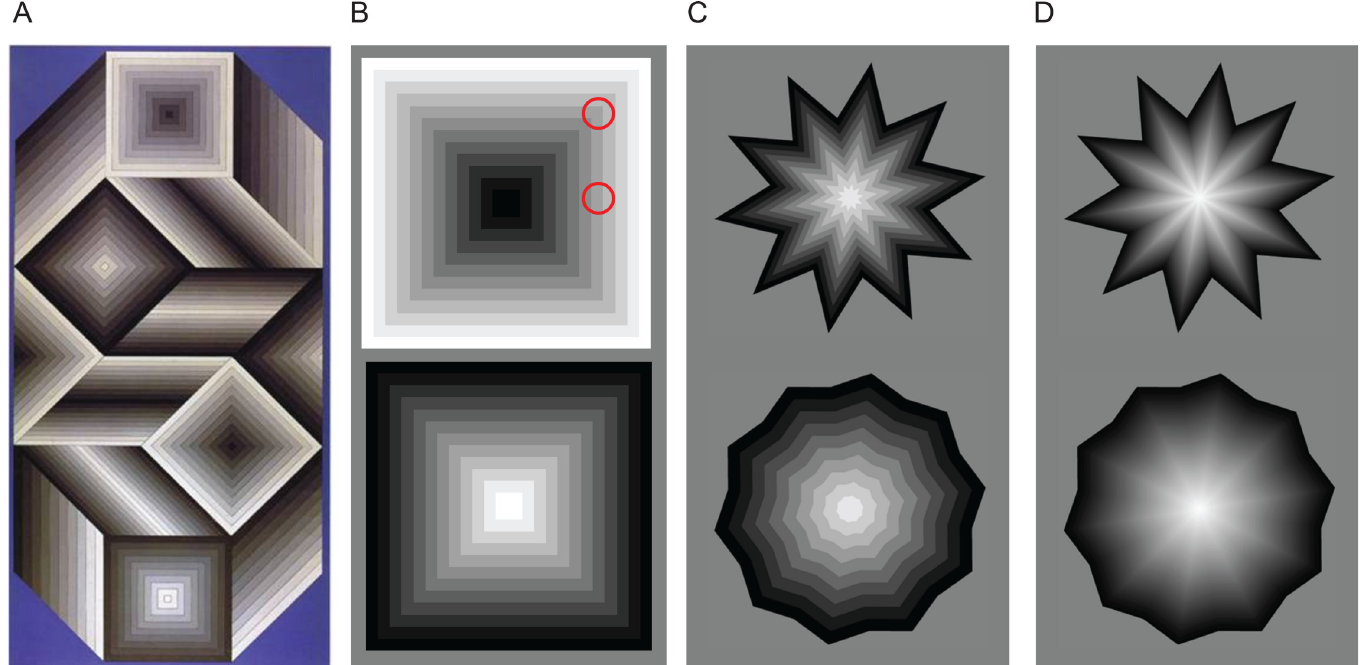
Fig 1. Vasarely’s nested-square and alternating brightness stars (ABS) illusions. Vasarely’s nested squares and ABS illusions. ( A ) Vasarely’s “Utem” (153 x 298 cm, 1981) [7]. Note the four sets of nested squares. The two nested squares of decreasing luminance (from the center to the outside) have bright illusory diagonals, whereas the two nested squares of increasing luminance (from the center to the outside) have dark illusory diagonals. The physical luminance of each individual square remains constant at all points, but the squares’ corners appear perceptually more salient than their straight edges, forming illusory X shapes that seem to irradiate from the very center of each set of squares. ( B ) Nested squares illusion based in Vasarely’s “Arcturus” [1]. Top: The stimulus is made out of multiple concentric squares of increasing luminance (from the center to the outside). The two red circles indicate two regions that seem to differ in brightness. The area inside the upper red circle has higher average luminance—but appears perceptually darker—than the region inside the lower circle. Bottom: Nested squares decreasing in luminance from the center to the outside. ( C, D ): The ABS illusion [2]. The stimulus is made of concentric stars of graded luminance. In the examples illustrated, the innermost star is white and the outermost star is black. The illusory corner-folds that radiate from the center appear as light or dark depending on the polarity of the corner angle (convex or concave). All illusory folds are physically equal to each other in luminance, but appear more salient with sharp corners (top stars) than with shallow corners (bottom stars). In (C) the gradient from the center to the outside has 10 luminance steps, making the individual stars forming the polygonal constructs easy to identify. In (D) the gradient from the center to the outside has 100 luminance steps. From [4].